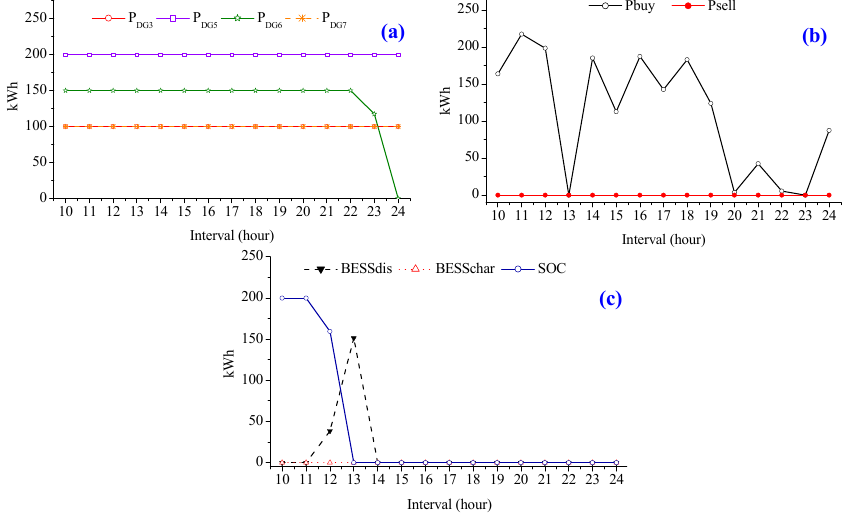
Figure 11. Operation results of normal part: ( a ) output power of DG units; ( b ) the amount of exchanging power; and ( c ) the charging/discharging amount and the SOC of BESS.